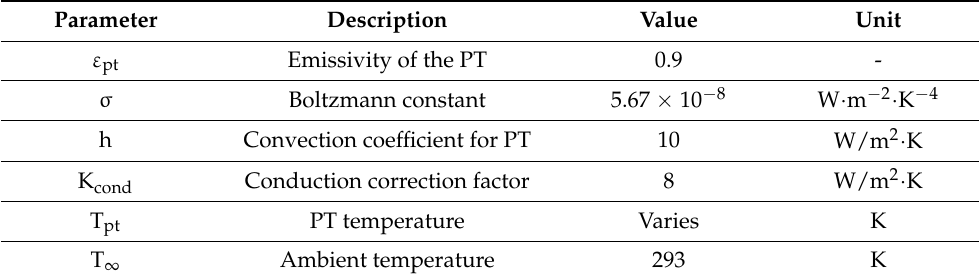
Table 1. Terms and constants adopted to estimate radiative heat flux to